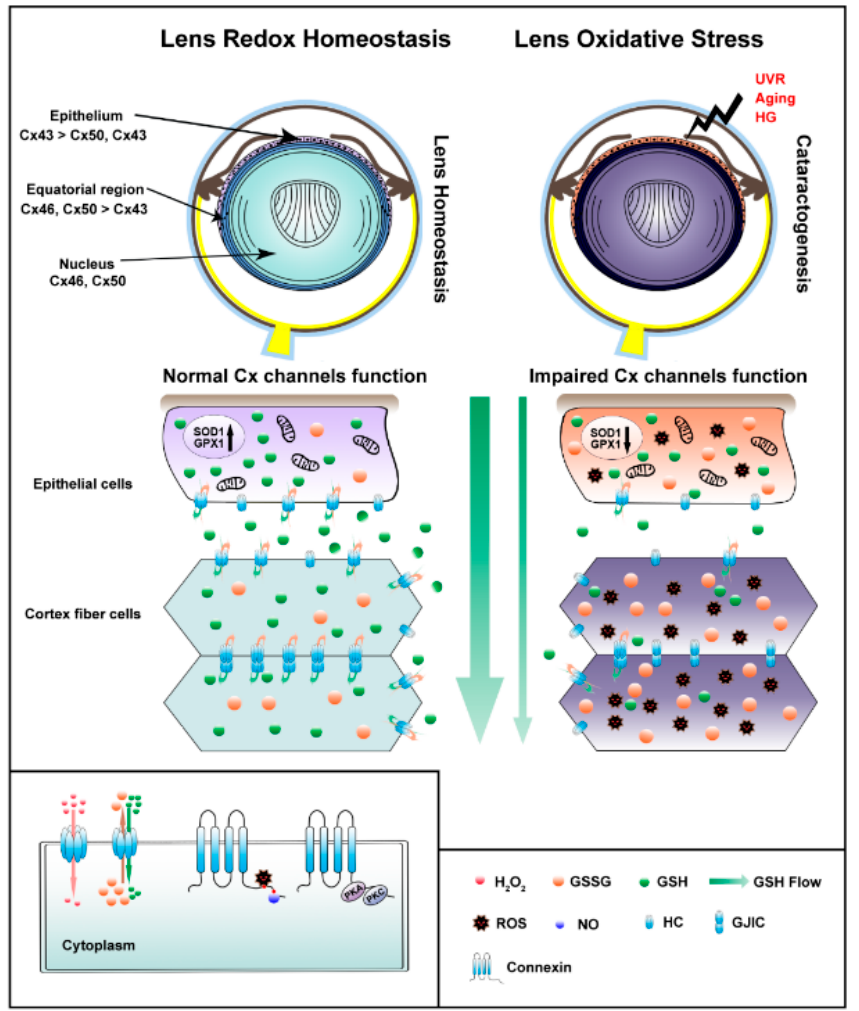
Figure 1. Illustration of connexin-forming gap junctions and hemichannels in the lens under normal and oxidative stress conditions. The distribution of connexin subtypes in various lens regions is shown ( upper panel ). At normal physiological conditions ( middle left panel ), the expression of antioxidant genes, such as superoxide dismutase 1 (SOD1) and glutathione peroxidase 1 (GPX1), is high, and glutathione (GSH) synthesized by lens epithelial cells is released possibly through connexin hemichannels. The extracellular GSH will be uptaken by cortical lens fiber cells through fiber connexin hemichannels and further delivered through gap junctions to inner lens fiber cells. The ratio of GSH and oxidized GSH (also known as glutathione disulfide, GSSG) is high in the normal lens. When the lens is continuously subjected to oxidative stress, due to (ultraviolet radiation) UVR, aging, or high glucose (HG) ( middle right panel ), expression of antioxidant gene expression is lower, and the biosynthesis of GSH is reduced in lens epithelial cells. This leads to reduced GSH release, and in the meantime, less GSH will be uptaken by cortical lens fiber cells. The reduced GSH level in lens cortical fiber cells will disrupt the balanced redox potential accompanied with elevated oxidant GSSG and reactive oxygen species (ROS), and lower GSH/GSSG ratio. Consequently, fewer reductants, but more oxidants will be transferred to the inner lens fibers through gap junctions. The compromised redox homeostasis will generate a vicious cycle, and resulted in elevated oxidative stress will lead to cataratogenesis. Connexins can be post-translationally phosphorylated at its C-terminus by protein kinases, such as protein kinase A (PKA) and protein kinase C PKC. Oxidative stress, such as H 2 O 2 and NO, can alter connexin phosphorylation, leading to changes in connexin hemichannel function ( bottom left panel ).